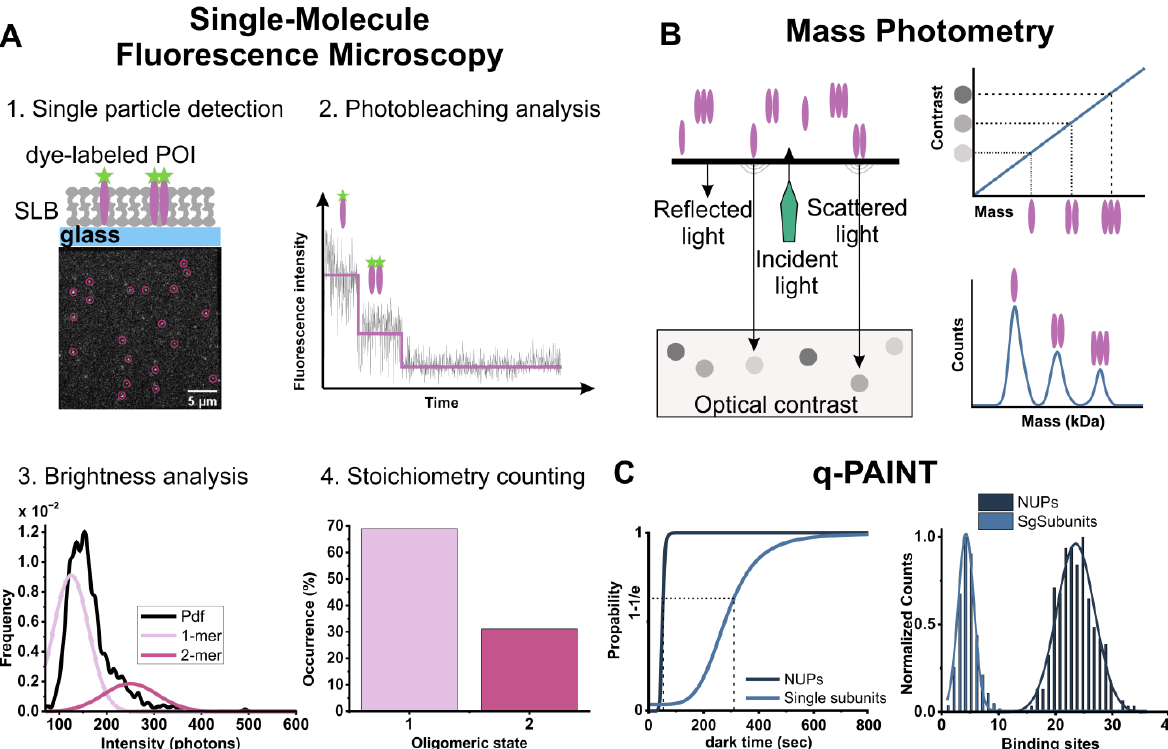
Figure 3. Techniques used to determine pore assembly via stoichiometric analysis. ( A ) 1: schematic representation of dye-labeled POI assemblies reconstituted in SLBs ( top ) and a TIRF representative image of fluorescently labeled protein complexes (bright spots, bottom ). Stoichiometric analysis via SM fluorescence microscopy involves the detection of single particles at the membrane surface (cir- cles in the image); 2 – 4: two analysis approaches (step-wise photobleaching and brightness analysis) can be used to determine the percentage of occurrence of the oligomeric species (see text for details). ( B ) Principle of mass photometry ( left ). MP detects the change in reflectivity caused by interference of reflected light and scattered light by biomolecules landing on a glass microscopy slide. Particle landing events appear as diffraction-limited events and the contrast of each event is proportional to the mass of the landed biomolecule ( upper right ). Recording the contrast of many events results in a distribution of the species in solution. After calibration with molecular weight standards, the light- scattering signals of single biomolecules can be converted into MWs and represented as an MW distribution ( bottom right ). ( C ) Stoichiometry qPAINT analysis of NUPs forming the nuclear pore complex. qPAINT enables the signal frequency to determine the number of binding sites; a high number of tagged molecules per structure results in an increased binding frequency of the imager strand and thus leads to a reduced dark time. Comparing the mean dark time to the dark time of a stoichiometrically known sample, used for calibration, allows the determination of the unknown number of subunits. ( Left ): signal frequencies as mean dark times are shown for single subunits and complete NUPs. ( Right ): distribution of binding sites for complete NUPs (dark blue) and single subunits (light blue).